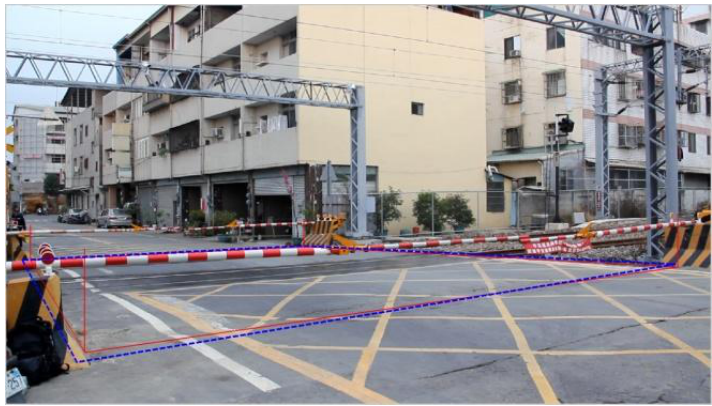
Figure 10. The detection result of the risk area, where the blue-line area is the detection result and the red-line area is the real measured